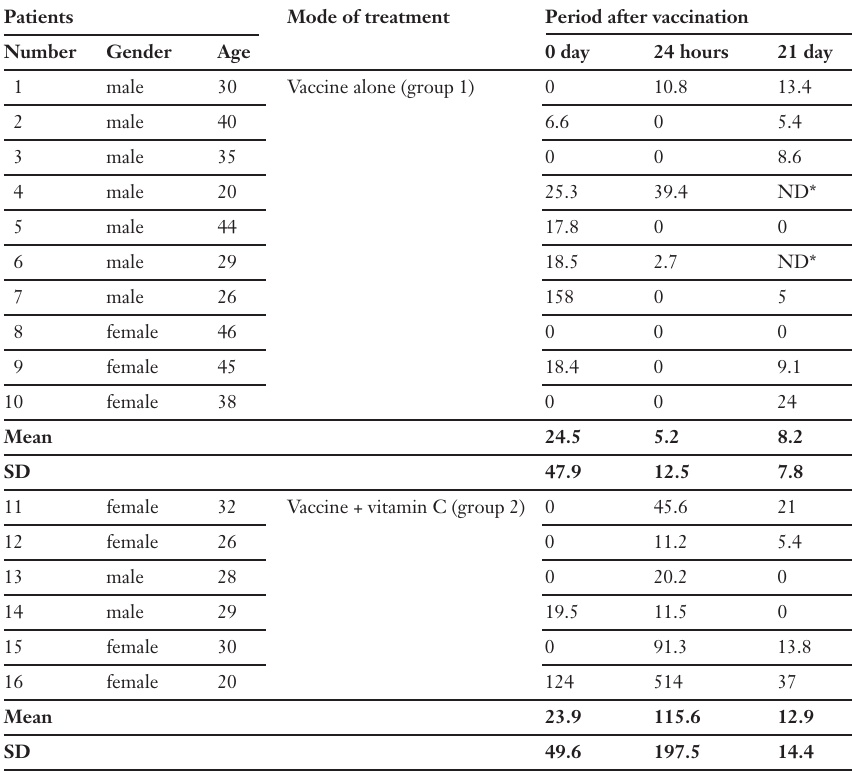
patients [6], a further improvement of the post-exposure treatment of rabies would be welcome. The existence of a huge reservoir